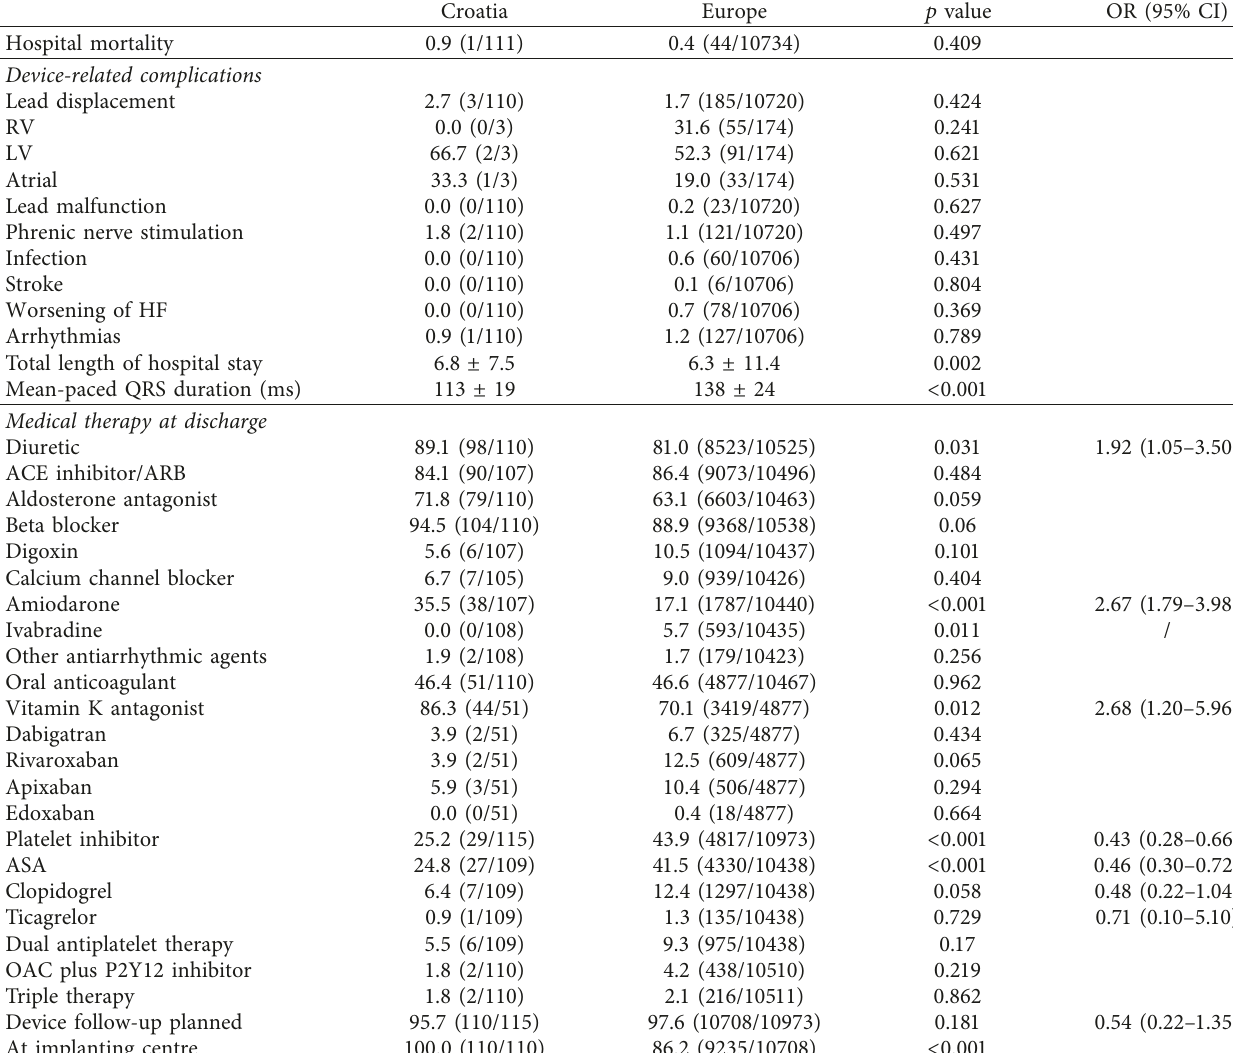
Table 3: Postprocedural data of Croatian CRT population and comparison with the European